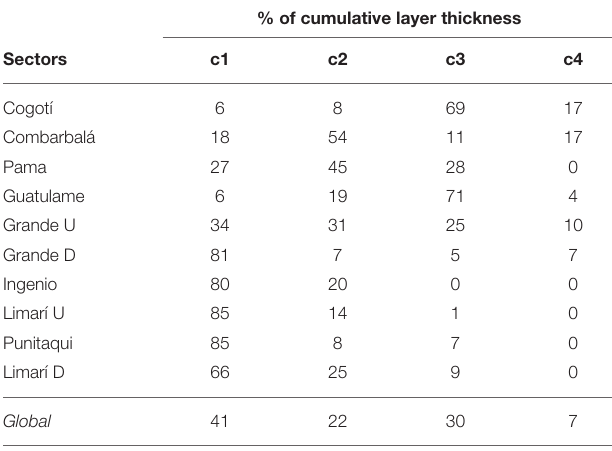
TABLE 3 | Summary statistics of the inverted resistivity values. The percentages correspond to the relative contribution of the resistivity class to the cumulative layer thickness of each sector and of all sectors for the global results.